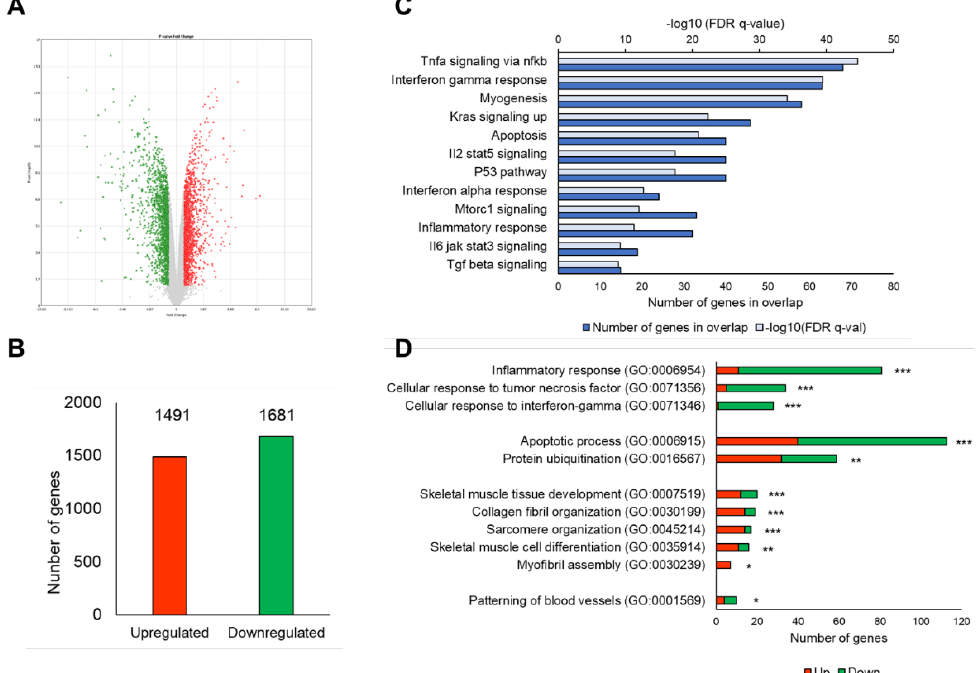
Figure 2. Microarray gene expression profile in gastrocnemius muscle 14 days after denervation. ( A ) Volcano plot showing the DEGs between MA group and control group. The Y-axis corresponds to -log10 ANOVA p -value and the X-axis displays the fold change. Up and downregulated DEGs are presented in the red and green dots, respectively. ( B ) Column graph displaying the number of DEGs. ( C ) Bar graph showing the significantly enriched Hallmark gene sets by the DEGs (MsigDB of GSEA). Significance was considered at false discovery rate (FDR) q-value < 0.05. ( D ) Bar graph showing the significantly enriched biological processes by the DEGs (from DAVID), with p -value as * p < 0.05, ** p < 0.01, *** p <